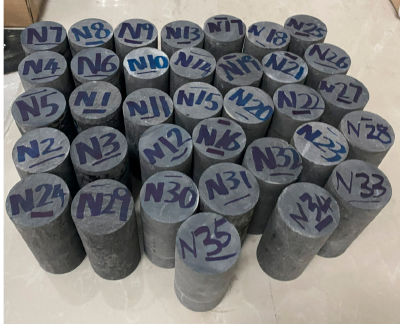
Figure 1. Core standard specimens.